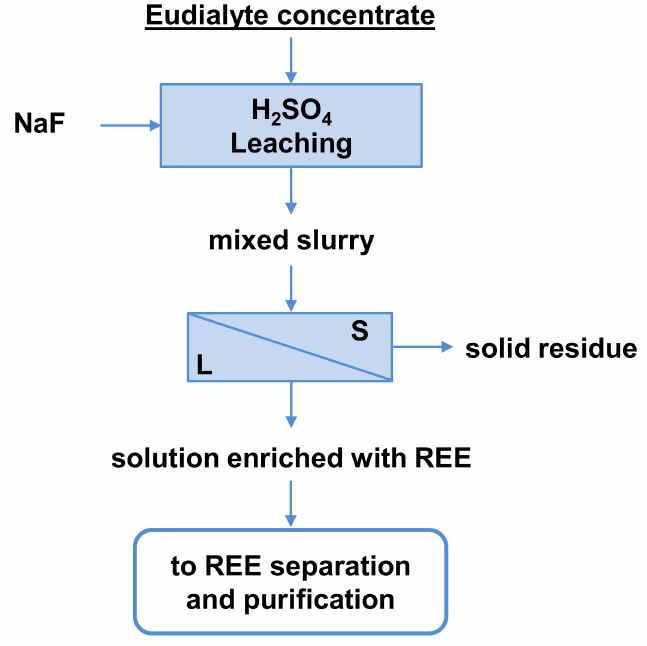
Figure 3. Treatment of eudialyte concentrate using sulfuric